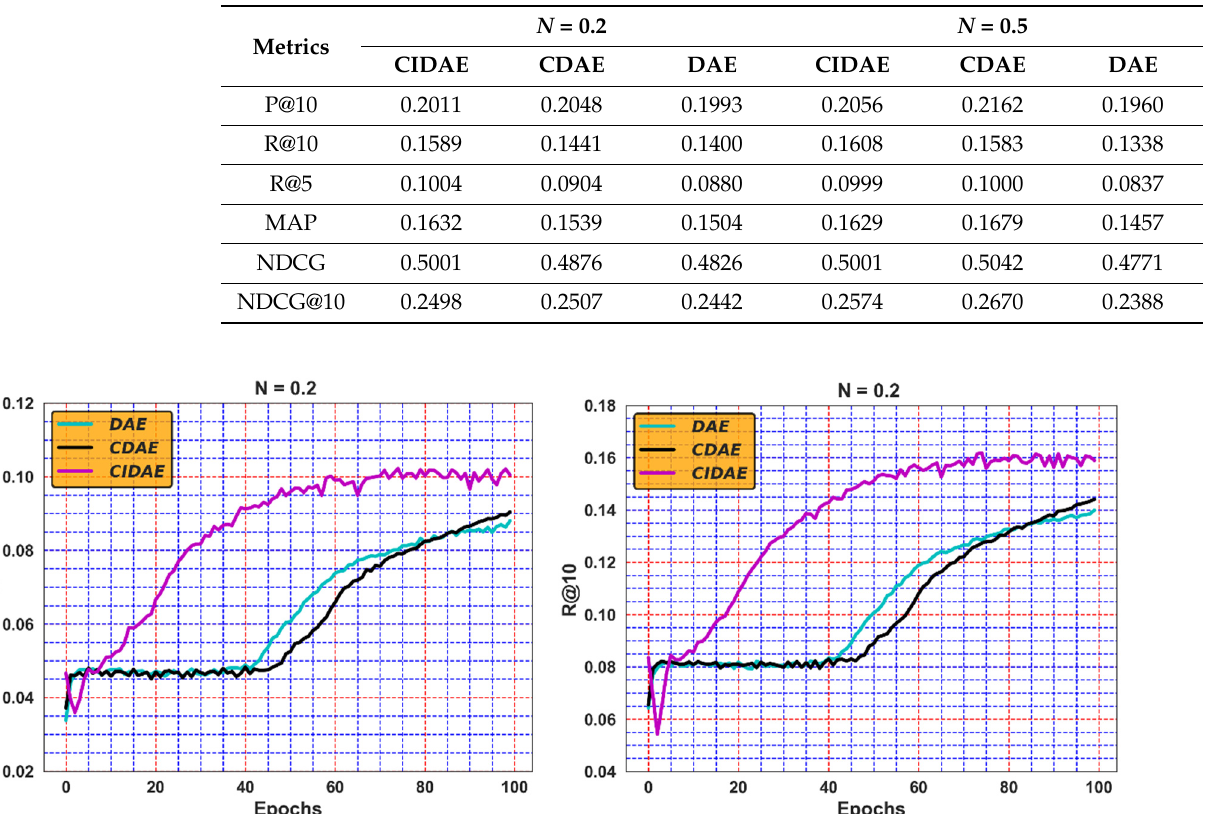
Table 4. Performance assessment for noise variations using ML-1M.